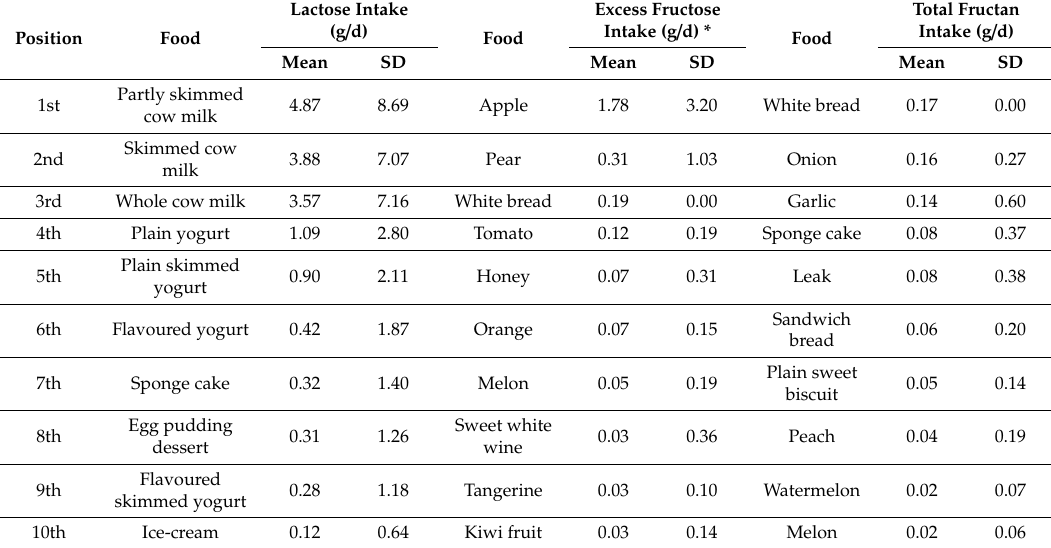
Table 4. Top ten foods representing the higher intake source of lactose, excess fructose and total fructan in Spanish diet of adult population.